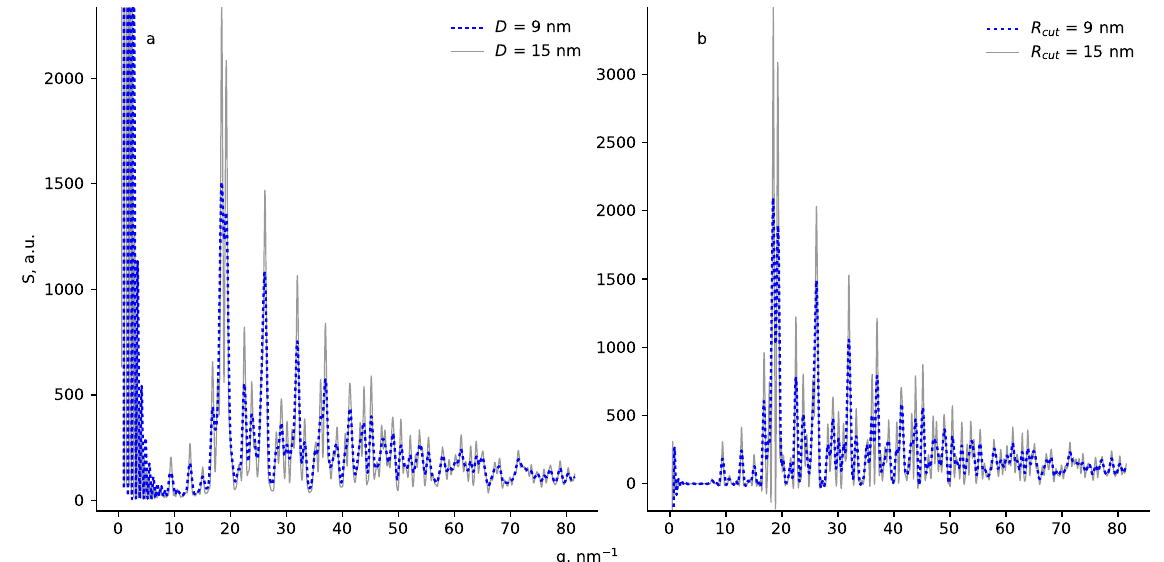
Figure 1: X-ray powder diffraction pattern calculated for nanocrystallites of AlCsF 4 (COD ID number: 1000106). The model samples are: (a) an isolated spherical nanoparticle with diameter D = 9 nm and D = 15 nm, (b) the solid nanocrystalline material with long-range order broken on the distances greater than R = 9 nm and R = 15 nm cut cut